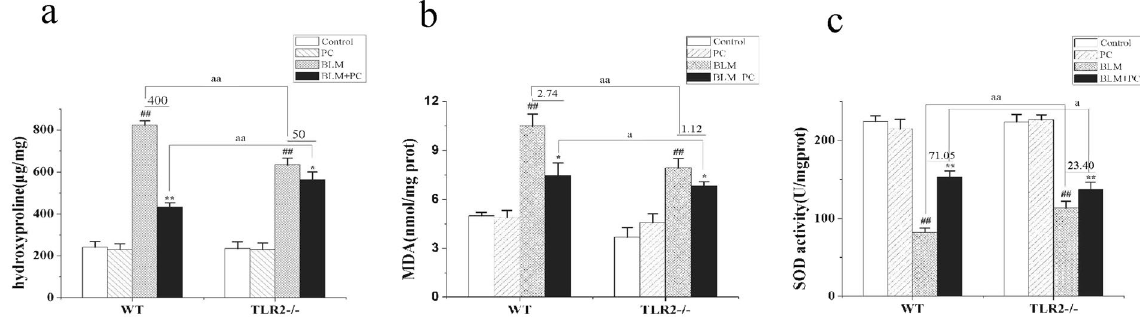
Figure 3. The effect of PC on lung HYP, MDA and SOD in BLM mice. After 28 days intervention, WT and TLR2 − / − mice were euthanized, and their lungs were removed. ( a ) HYP content. ( b ) MDA content. ( c ) SOD activity. Data were expressed as mean ± SEM, (n = 6). ## p < 0.01 compared with the control group, ** p < 0.01 compared with the BLM group. aa p < 0.01 compared with WT mice.